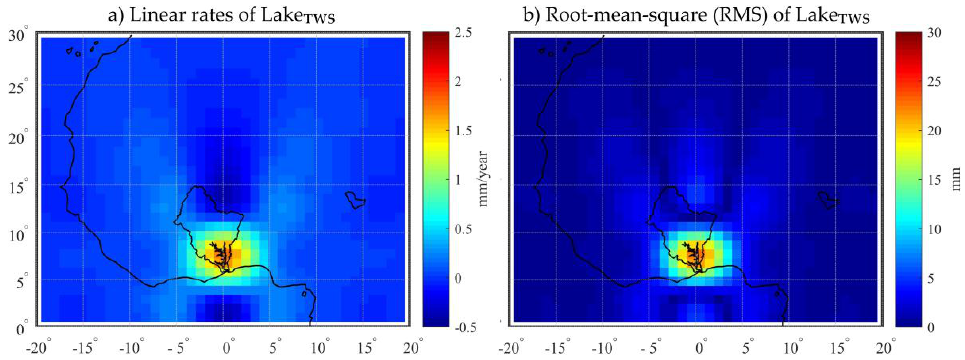
Figure 5. Panel ( a ) shows the linear rates (mm/year) of Lake TWS . Panel ( b ) shows the root-mean-square (RMS) of Lake TWS time series.